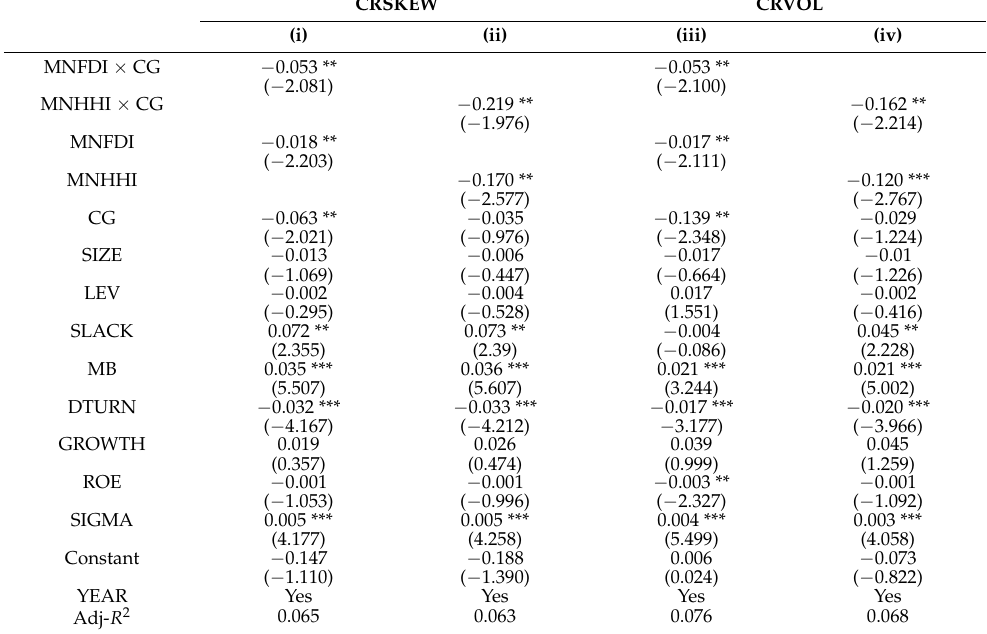
Table 6. Moderating Effect of Corporate Governance on Multinationality and Crash